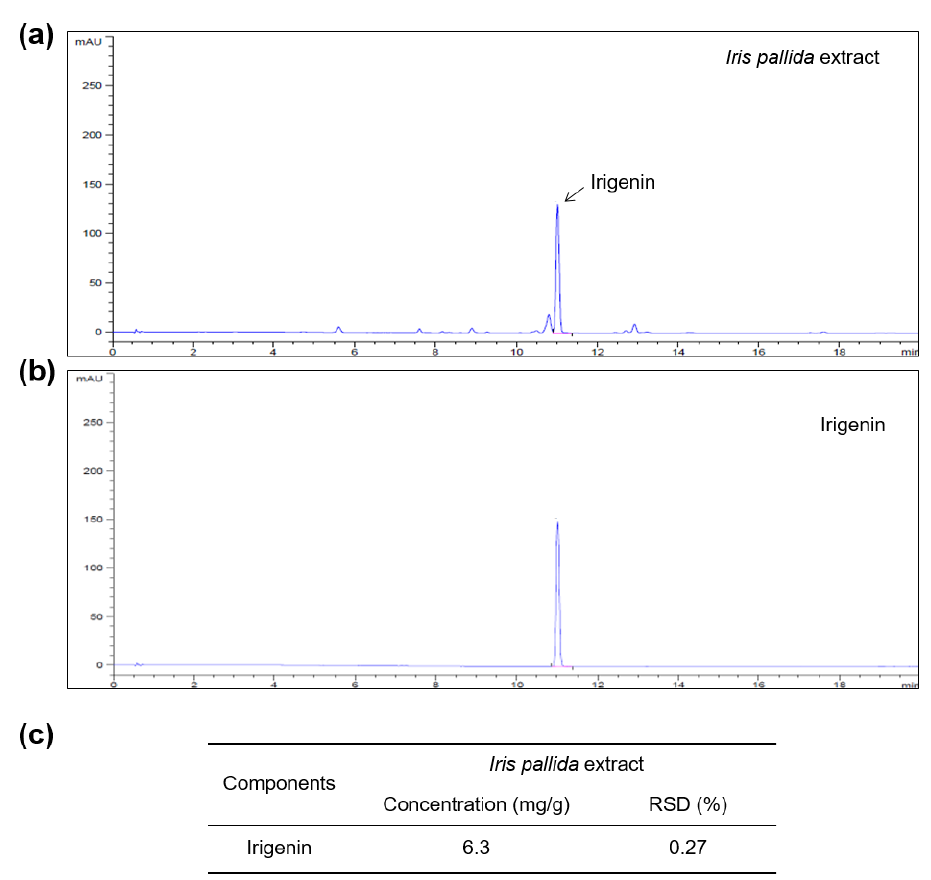
Figure 5. Phytochemical analysis of IPE. ( a , b ) High-performance liquid chromatography-diode array detection chromatograms of IPE with irigenin as the standard. ( c ) Quantification of irigenin identified in IPE. RSD, relative standard deviation.